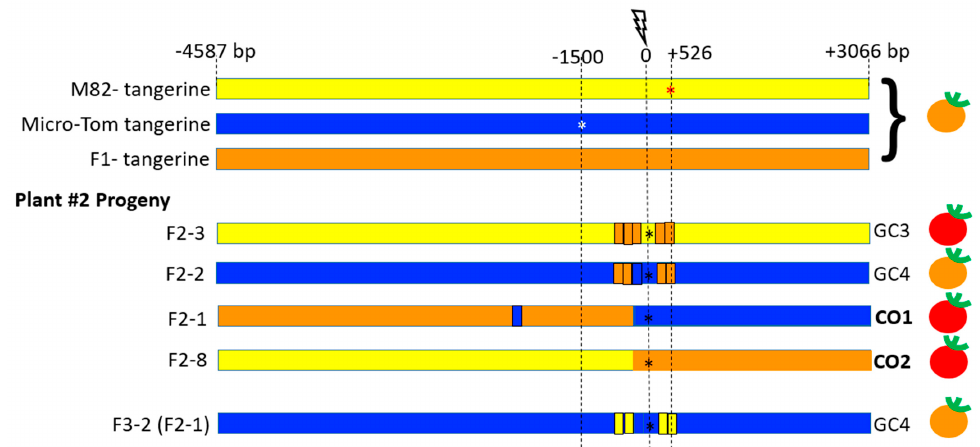
Figure 6. Schematic representation of IHSR events in the CRTISO 8–9 region around the targeted DSB in plant #2. The lightning bolt represents the CRISPR/Cas9 DSB site in the intron between exons 8 and 9 of the CRTISO locus. The DSB was induced between the two mutations in the tangerine alleles in the backgrounds of M82 (red star, 1500 bp upstream from the DSB) and Micro-Tom (white star, 526 bp downstream of the break). The F 1 has also a tangerine phenotype, unless an IHSR event occurs. In progeny of plant #2 where a red fruit sector was observed, two types of gene conversion events were observed as well as two putative crossover events. The GC3 conversion tract was similar in sequence to GC2 in plant #1 and gave rise to a red fruit. GC4 did not restore gene activity, even though it corrected the M82 mutation but it was homozygous for the Micro-Tom mutation. The two putative crossover events both gave rise to red fruits; CO1 had a conversion tract and CO2 did not show evidence for a conversion tract. The fruit color phenotype is indicated on the right side. All plants showed NHEJ DSB repair footprints that occurred in the intron, probably following recombination (black star). A full detail of the various alleles’ sequences in all progeny is shown in Supplementary Figure S3.